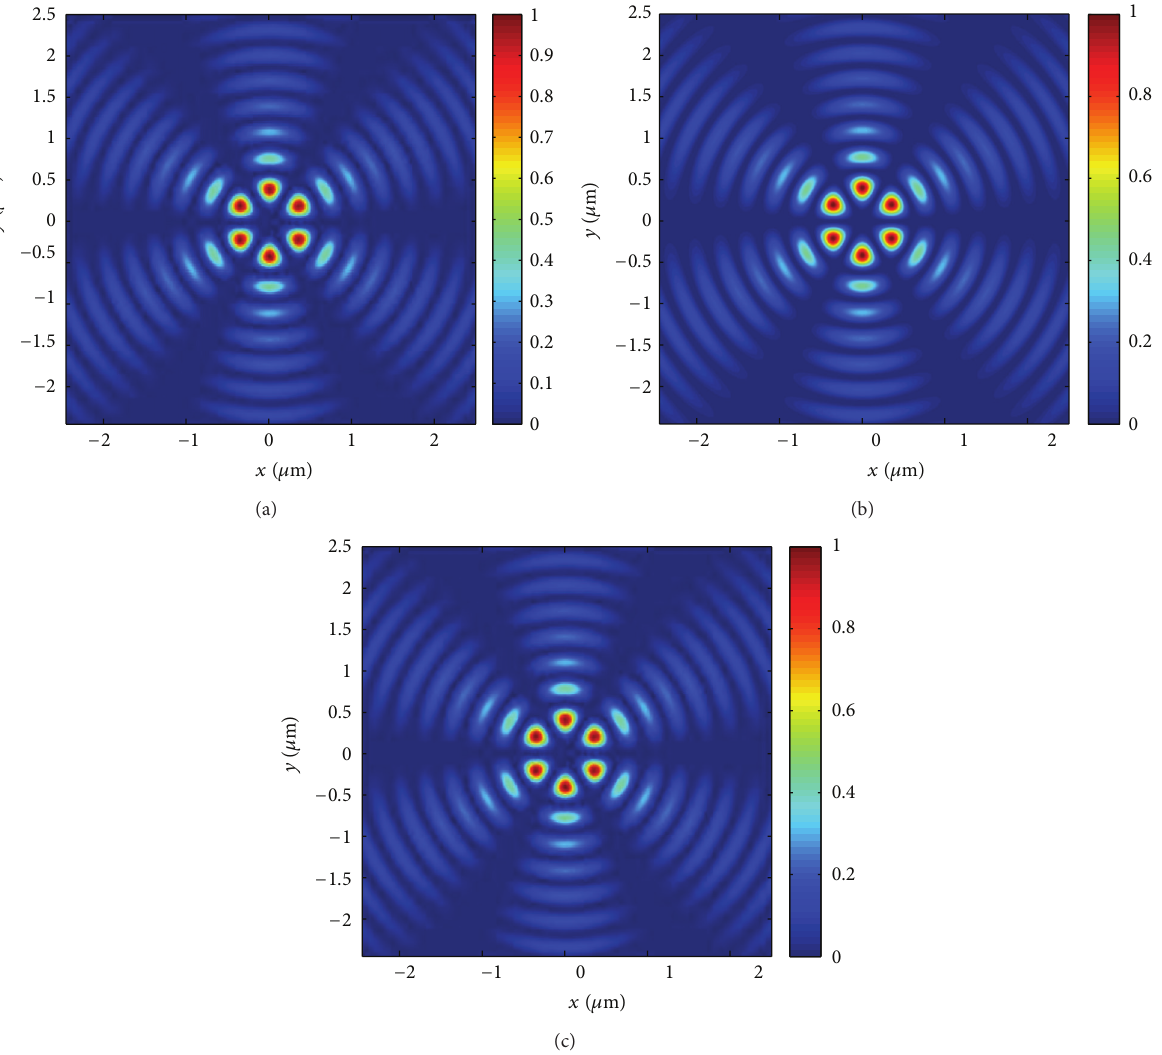
2 max of Bessel surface multiplasmon polariton in the air at the distance